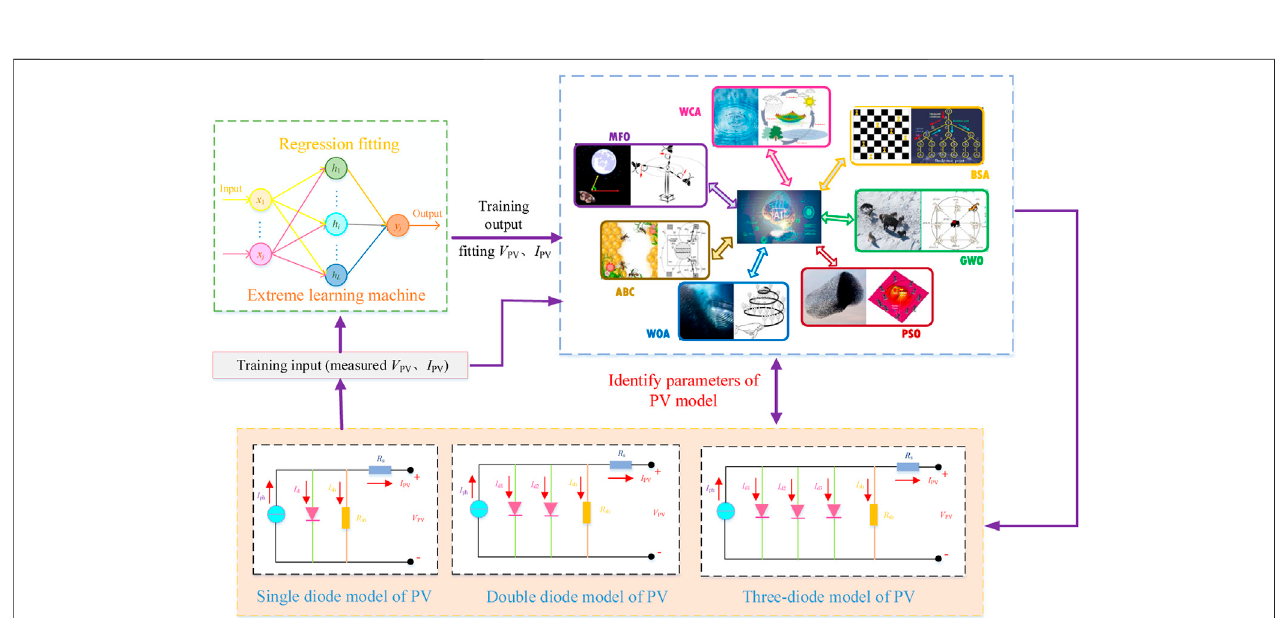
FIGURE 1 | Basic structure of ELM